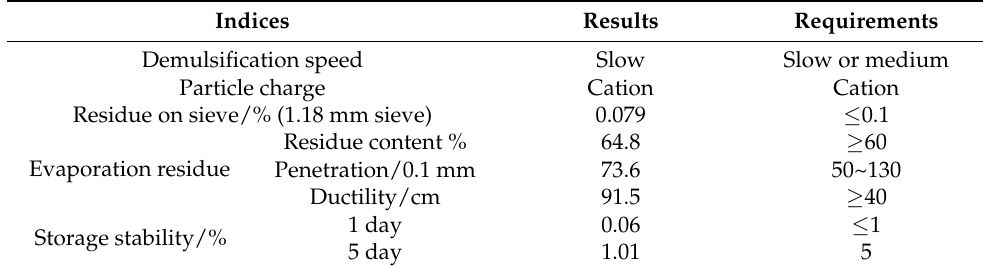
Table 5. Performance indices of emulsified